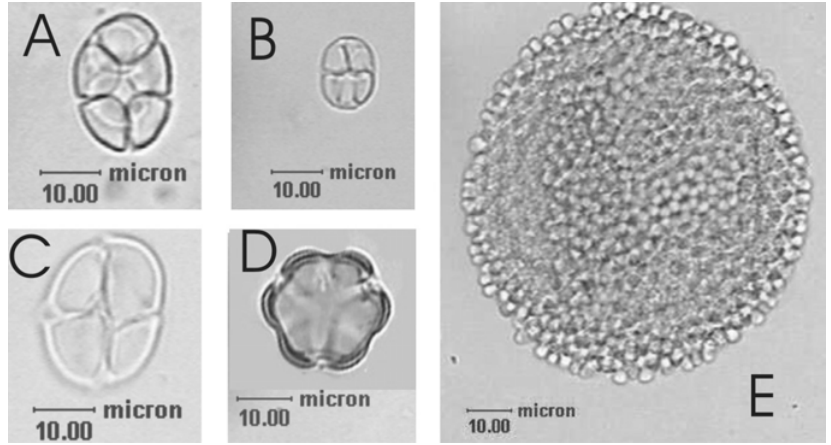
Fig. 2 – Dominant pollen types found in 38 Apis mellifera honey samples from the State of Piauí. A – Piptadenia sp. (Mimosaceae); B – M. caesalpiniaefolia (Mimosaceae); C – Mimosa verrucosa (Mimosaceae); D – Tibouchina sp. (Melastomataceae); E – Croton urucurana